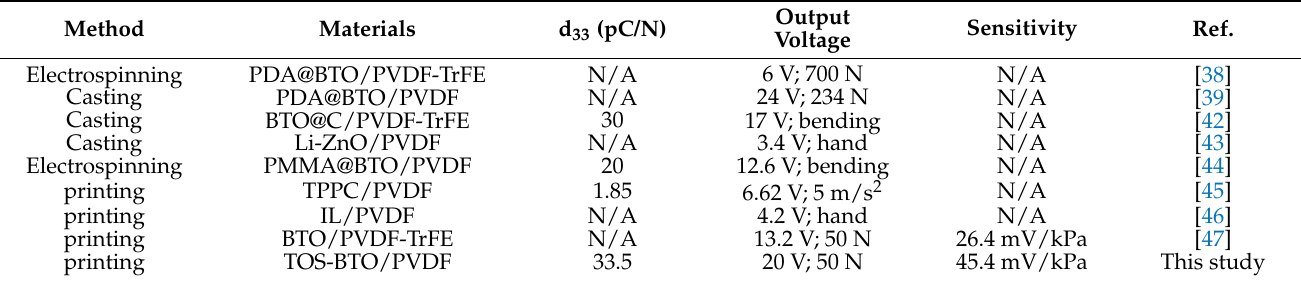
Table 1. Comparison of the output performance of PVDF-based PENGs. Method